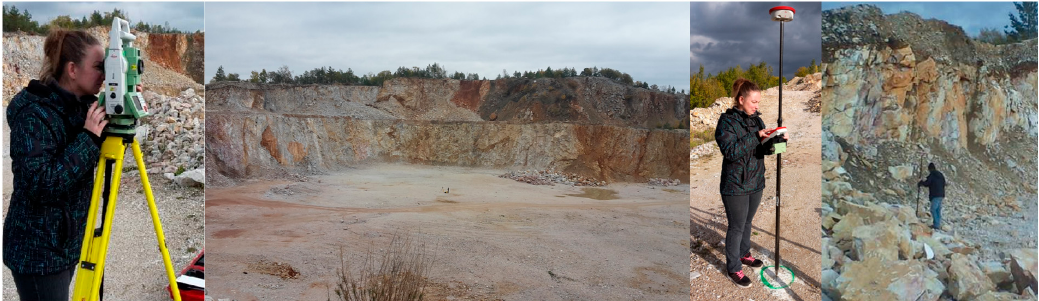
Figure 6. Used instruments for measurement of the open-pit mine.